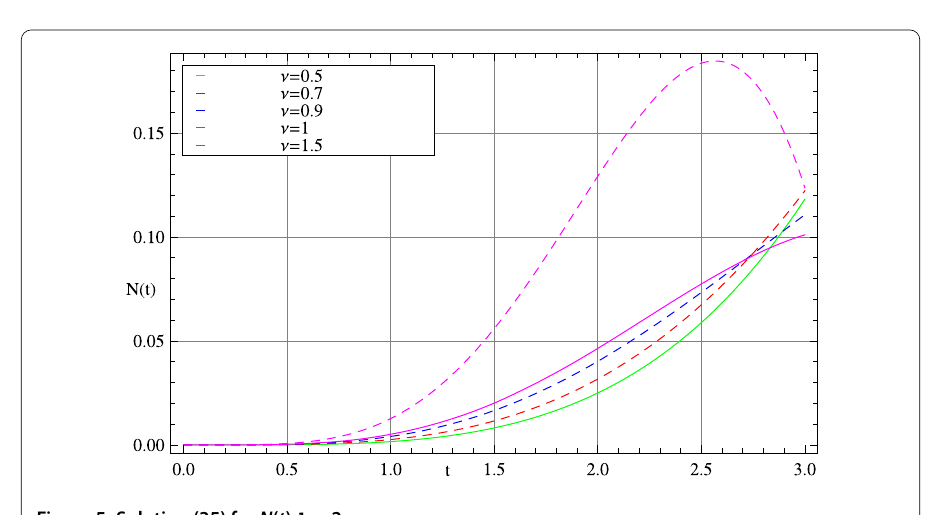
Figure 5 Solution (35) for N ( t ), k = 2.